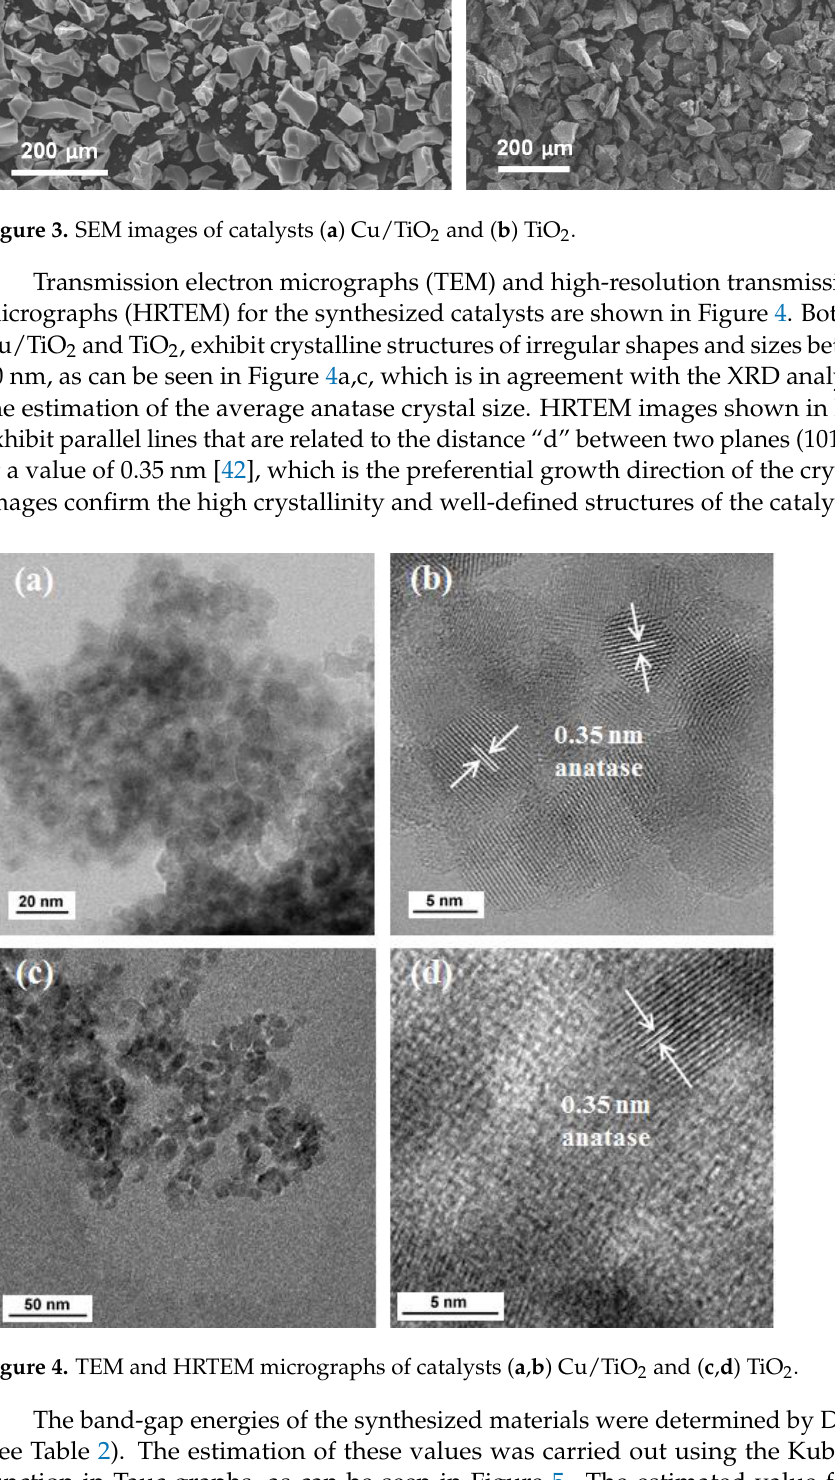
Figure 5. Tauc graphs for band-gap energies of synthesized catalysts. Inset: DRS spectra for each catalyst.